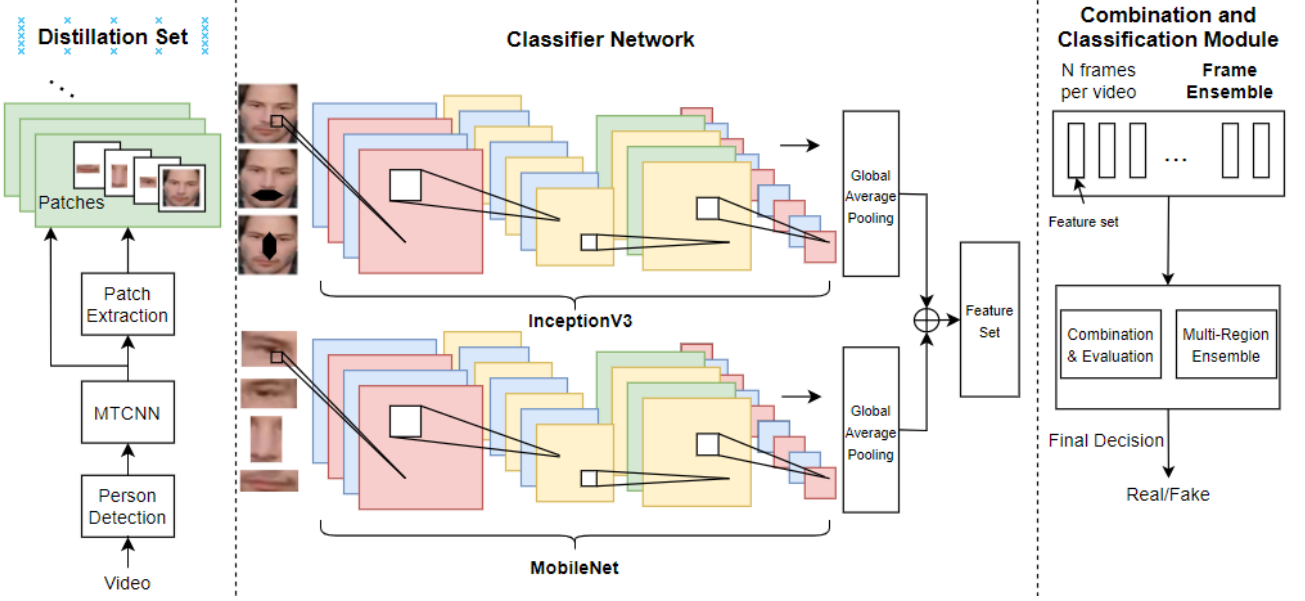
Figure 4. An overview of the proposed DeepFake detection method. If we analyze and evaluate the output of the classifier network (feature sets) to make decision as “Real” or “Fake”, we will get DeepFake detection for images. However, because the frames and regions are not combined, the results are often lower than the model with combination and classification